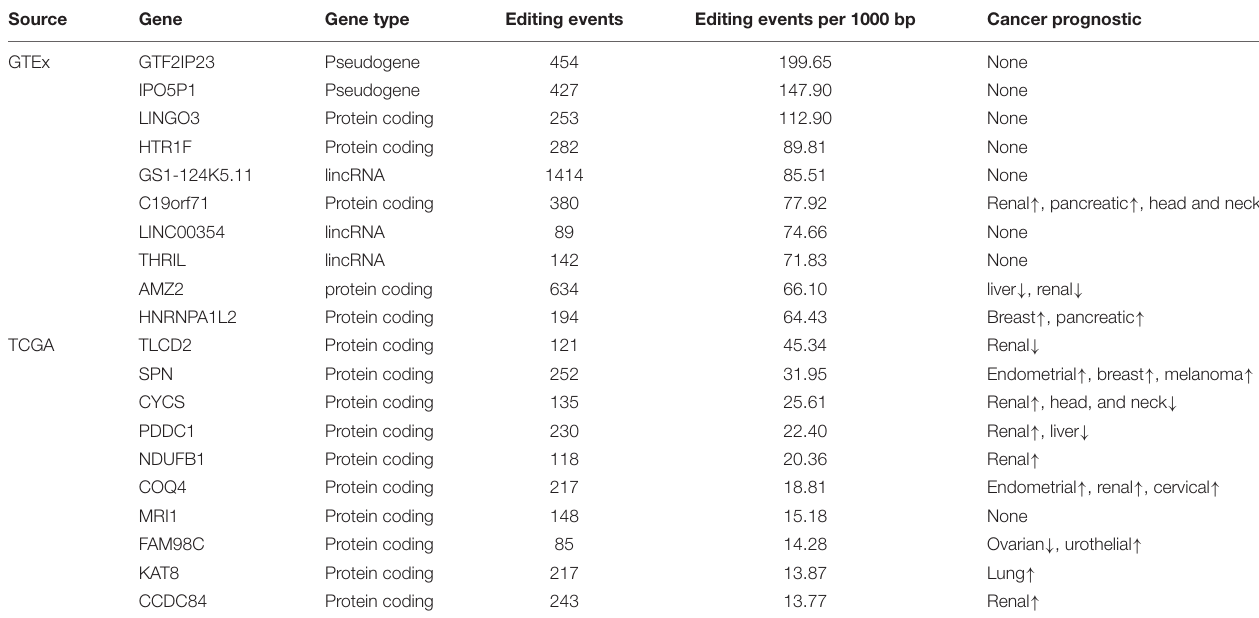
TABLE 2 | Hyper RNA editing